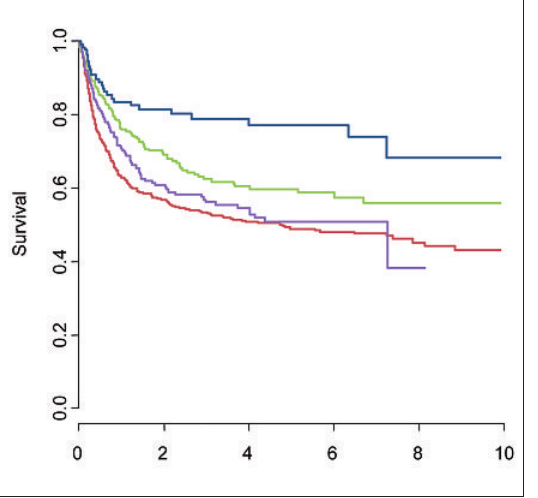
Figure 4a Survival by centre, allogeneic HSCT.